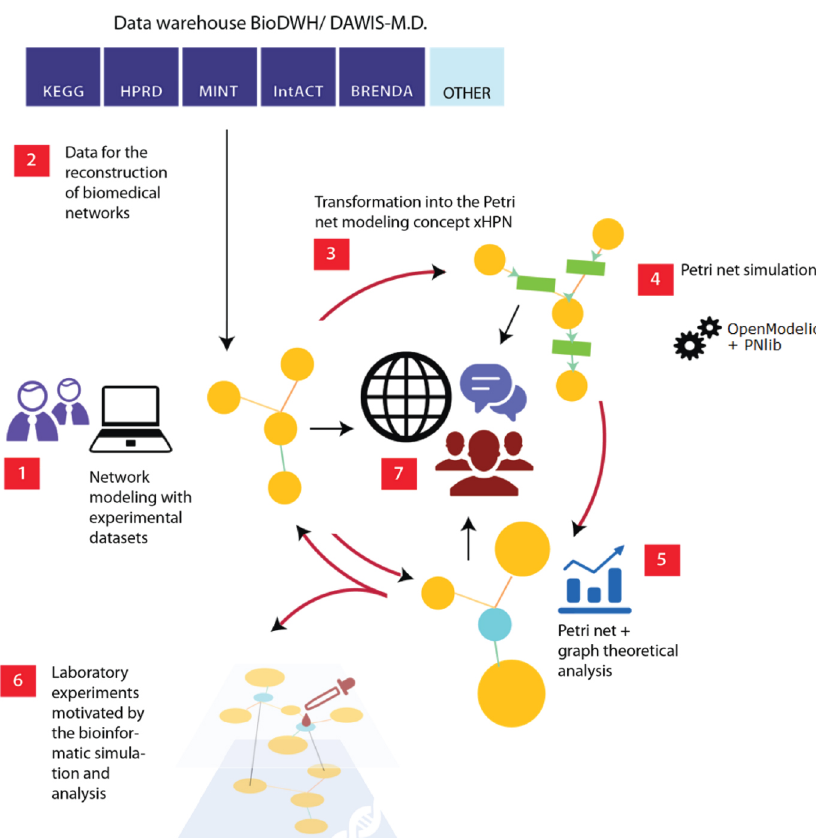
Figure 1: Workflow of VANESA: (1) create biological network using prior knowledge, (2) use the data warehouse, (3) transform biological network into Petri net, (4) perform Petri net simulation, (5) analyze Petri net and biological network, (6) insights could lead to new experiments and (7) share network with others